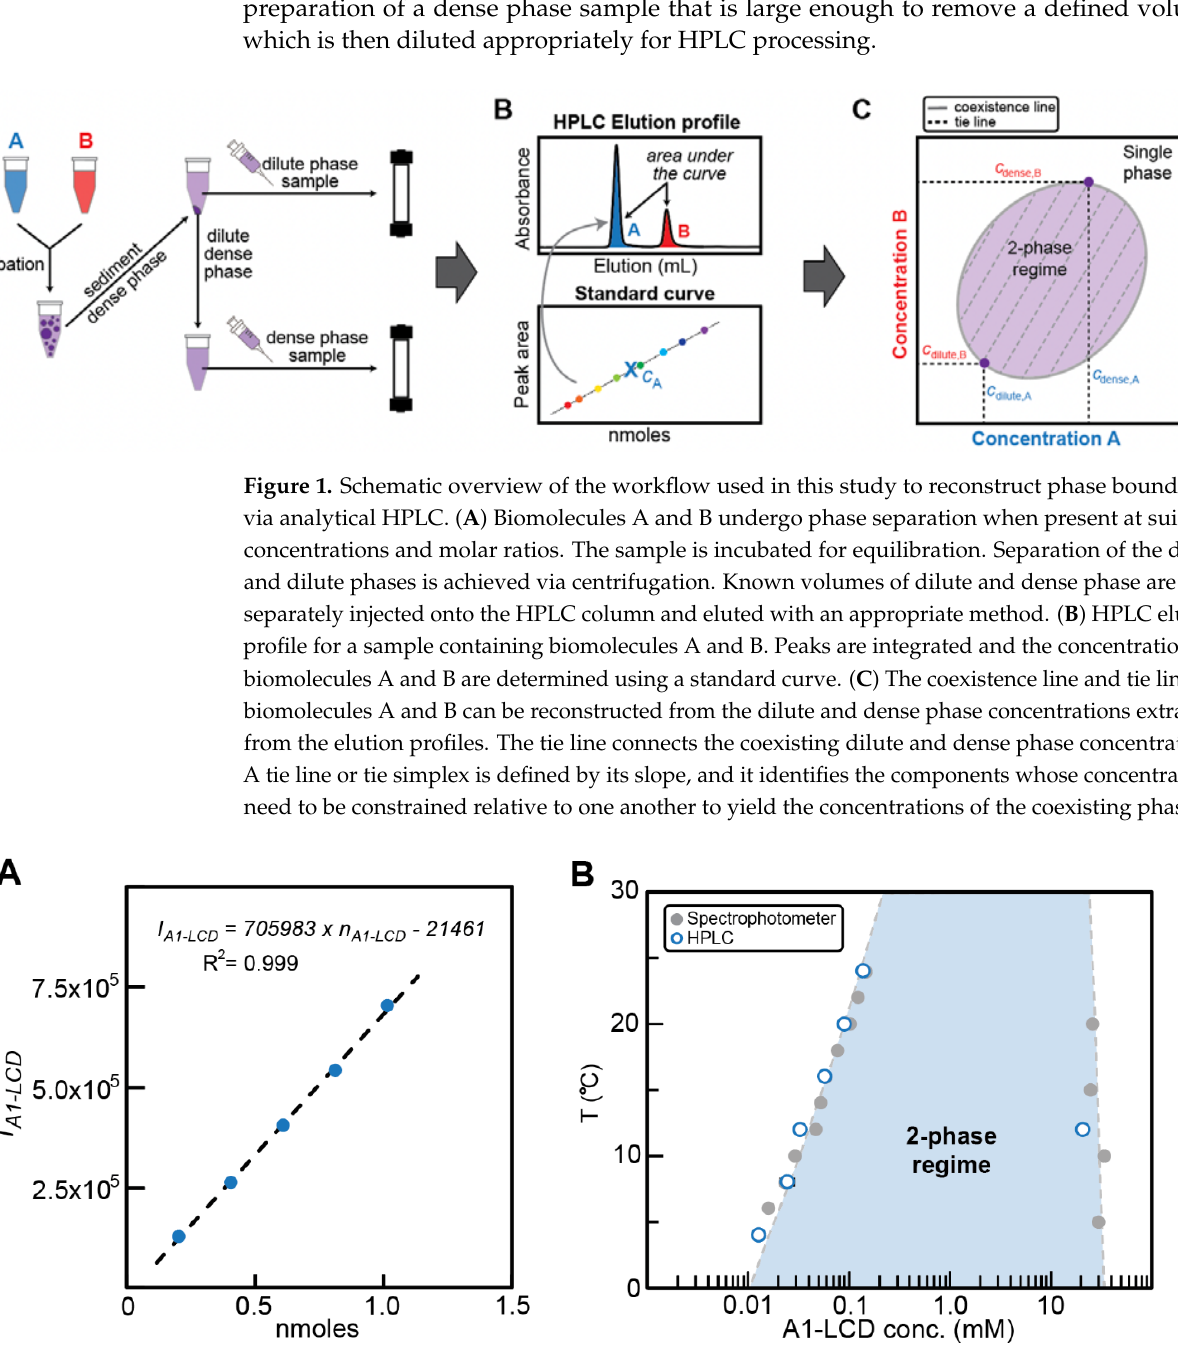
Figure 2. Determination of c sat and c dense by analytical HPLC. ( A ) The standard curve for A1-LCD was determined by plotting the area under the HPLC elution peak ( I A1-LCD ) from injections of differ- ent amounts of A1-LCD, n A1-LCD in nmoles. ( B ) Comparison of c sat and c dense values obtained via measurements using HPLC vs values from UV absorption measurements by spectrophotometer for A1-LCD as a function of temperature [36]. The dashed line represents a fit of the Flory Huggins equa- tion to the spectrophotometer data. The shaded area thus represents the 2-phase regime determined by the coexistence concentrations and other extant data [35,36] .